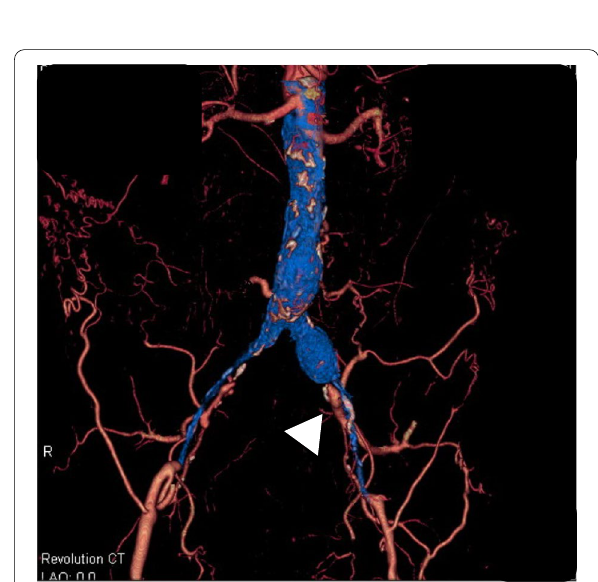
Fig. 4 CT angiography revealed the left internal iliac artery was also not completely occluded (white